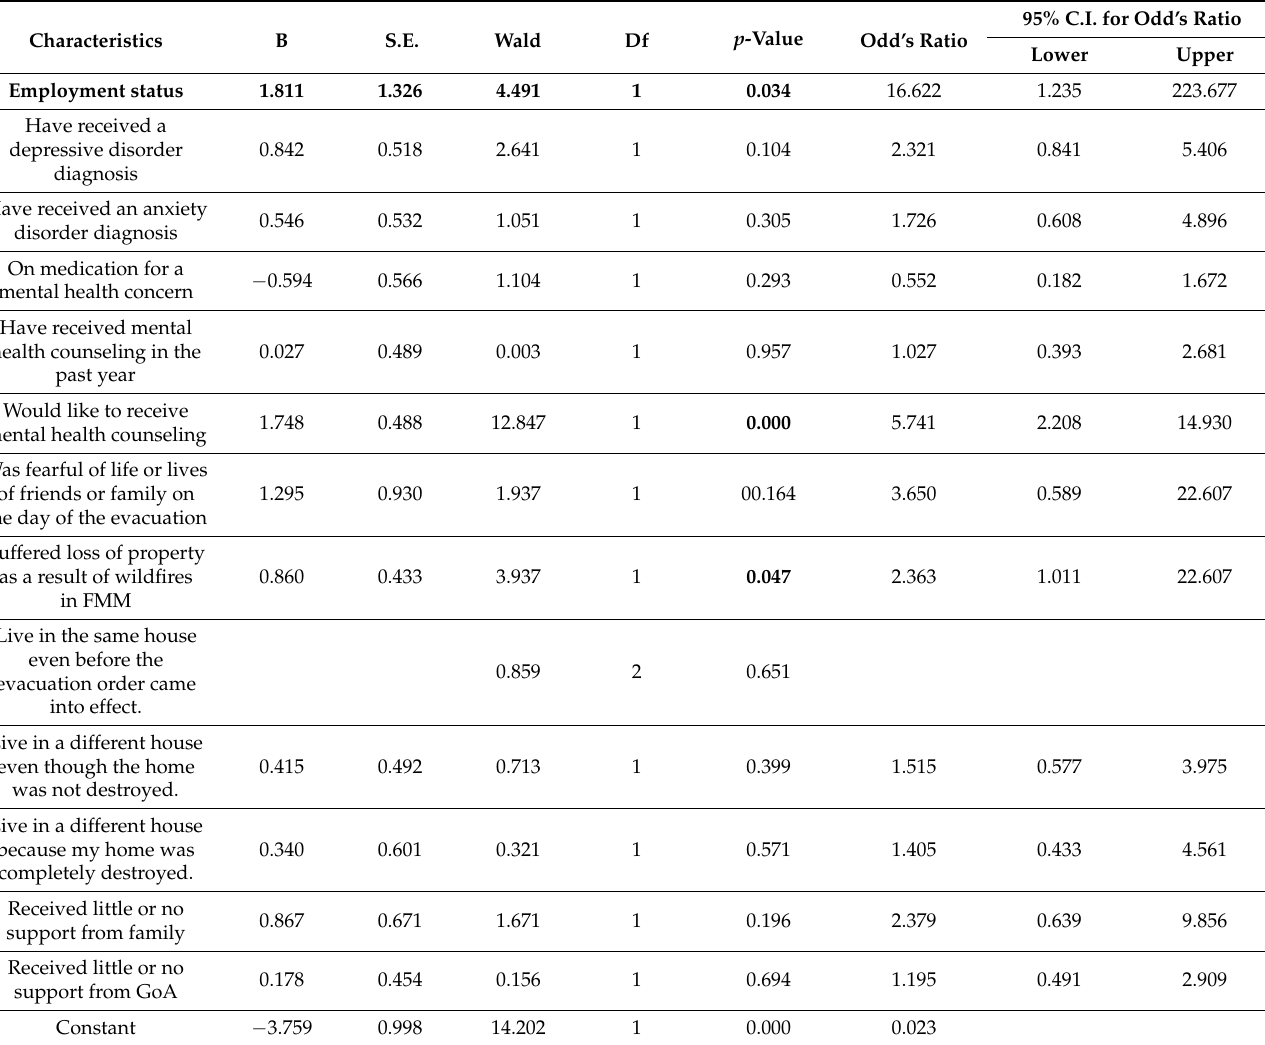
Table 3. A multivariate logistic regression model that predicts the likely anxiety among